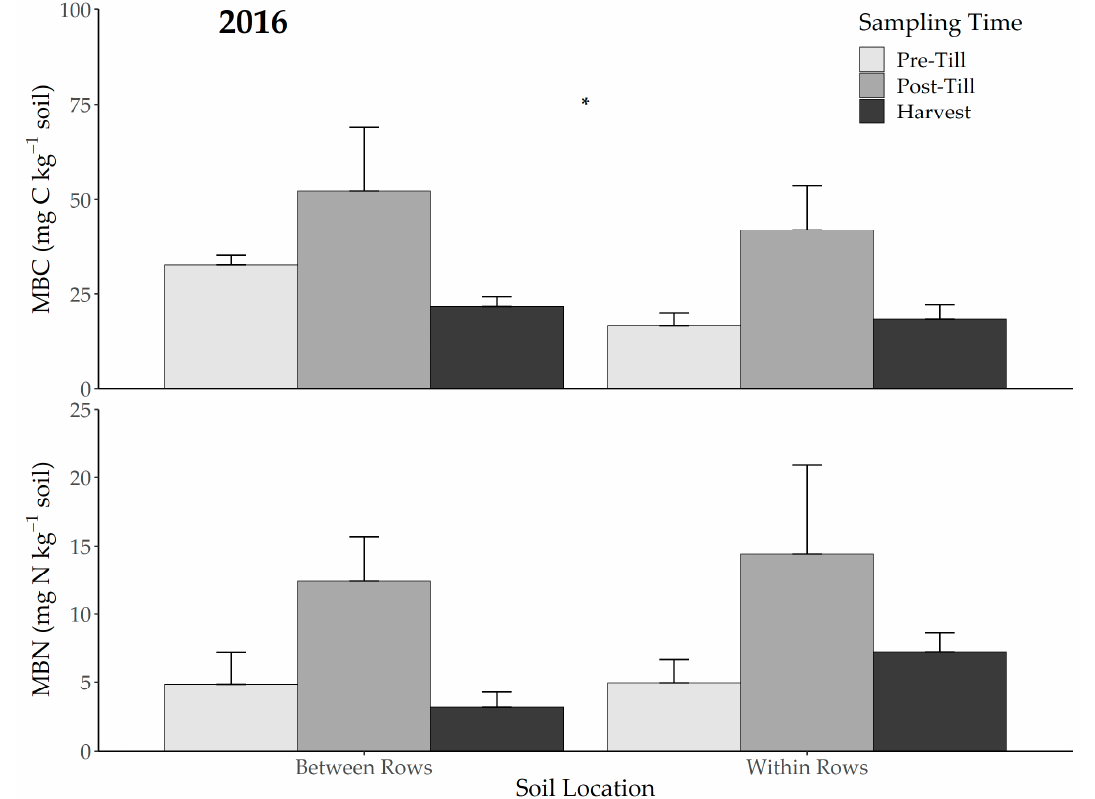
Figure 2. Effect of soil location and sampling time on microbial biomass carbon and nitrogen (MBC and MBN, respectively) in 2016. Error bars represent one standard error. Asterisks represent a difference between soil locations across sampling time ( p < 0.1).